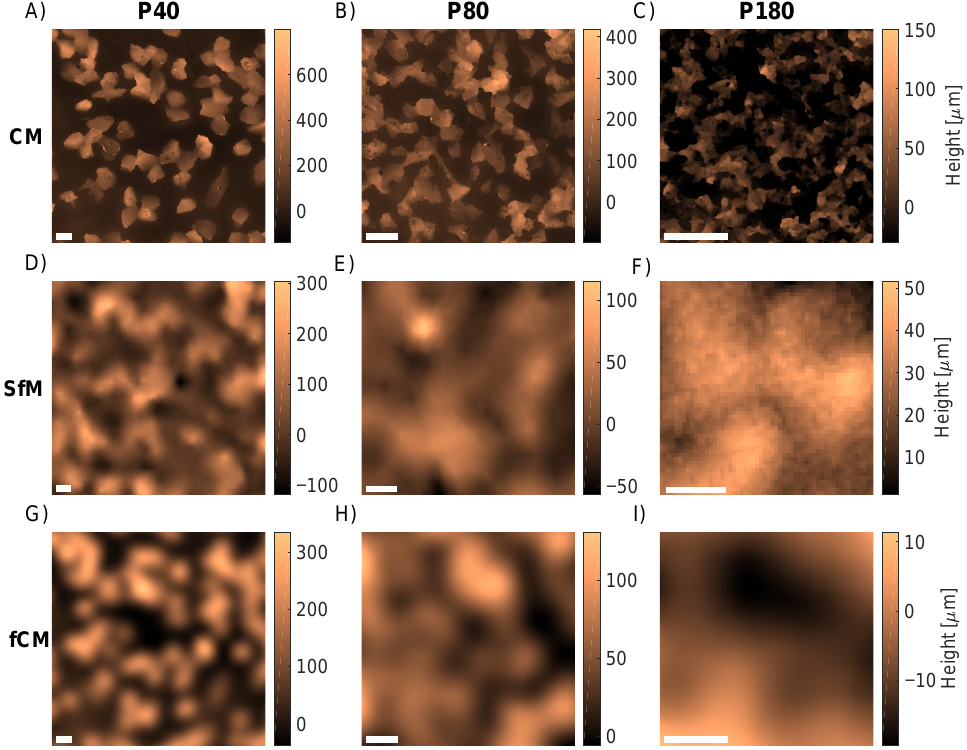
Figure 8. Topographic maps of sandpaper artifacts with grits P40, P80 and P180. CM (top row), SfM (middle row) at 1.7 m range, and fCM (bottom row) after Gaussian filtering with σ = 0.21 mm. ( A , D , G ) P40. ( B , E , H ) P80. ( C , F , I ) P180. The width of the scale bar is 0.5 mm in all panels. Note that CM and SfM have been measured at different sample